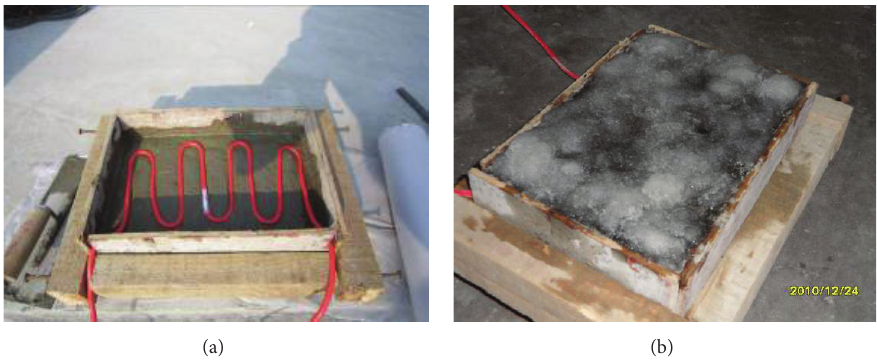
Figure 11: Laying of heating cable in the laboratory experiment.